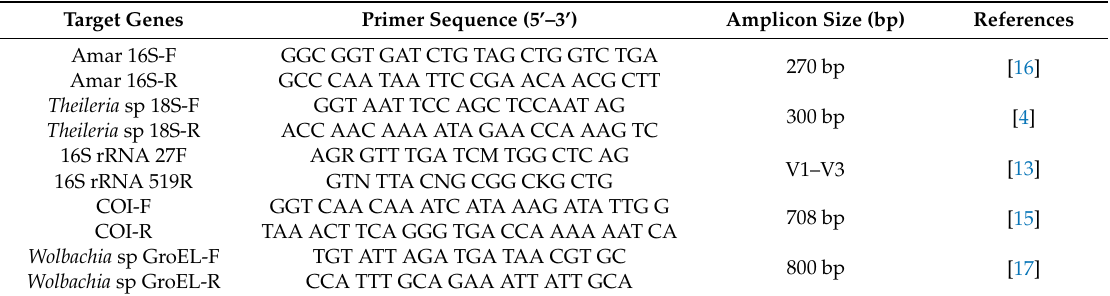
Table 1. List of primers used in this study and their respective amplicon